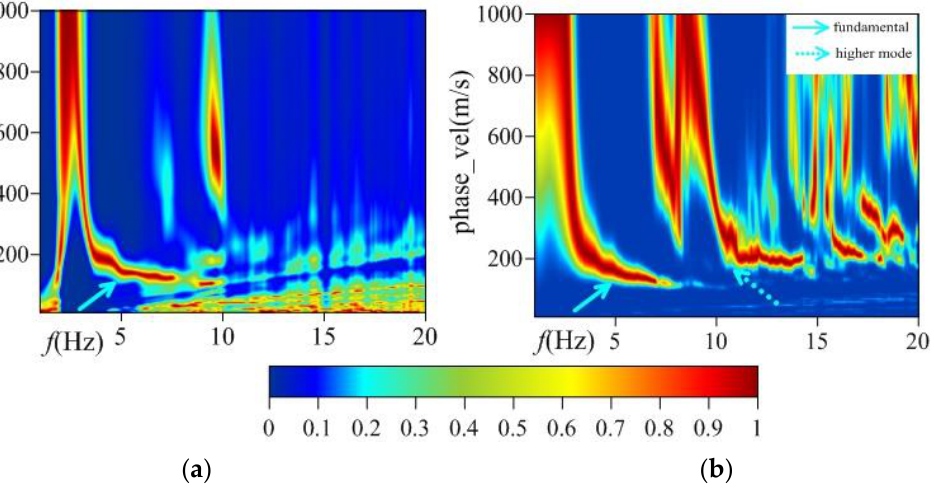
Figure 5. Comparison diagram of dispersion energy spectrum of measured data. ( a ) Dispersion spectrum of the spatial autocorrelation method. ( b ) Dispersion spectrum of the frequency-Bessel transform method.